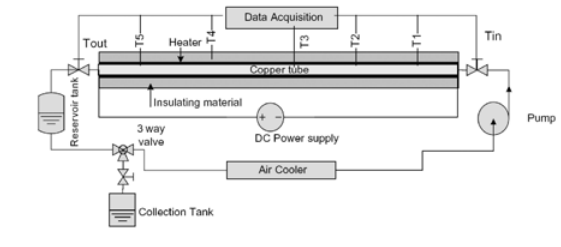
Fig. 7(a): Horizontal system